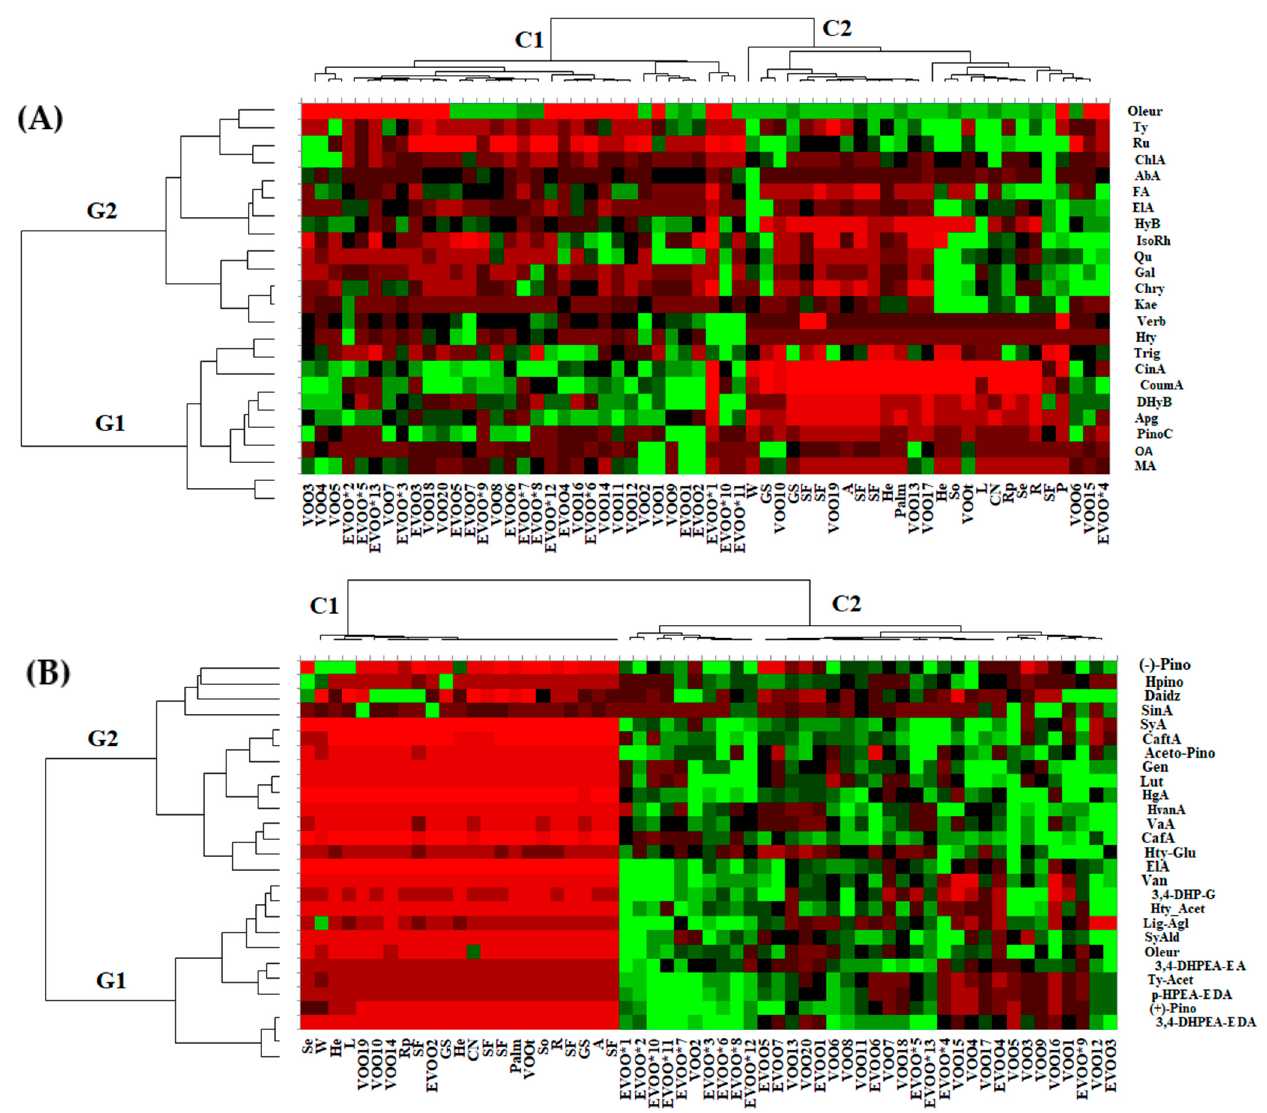
Figure 4. The heat map of discriminant features according to the different type of vegetable oils (red and green cells correspond to low and high compounds levels, respectively. Columns are oil samples and rows are compounds colored by behavior distribution among different oil types). ( A ) Targeted HRMS analysis of phenolic compounds and triterpenic acids biomarkers and ( B ) untargeted HRMS screening analysis. Color scale: red (higher values) to green (lower values) through black. (EVOO*—authentic extra-virgin olive oils; EVOO—commercial extra-virgin